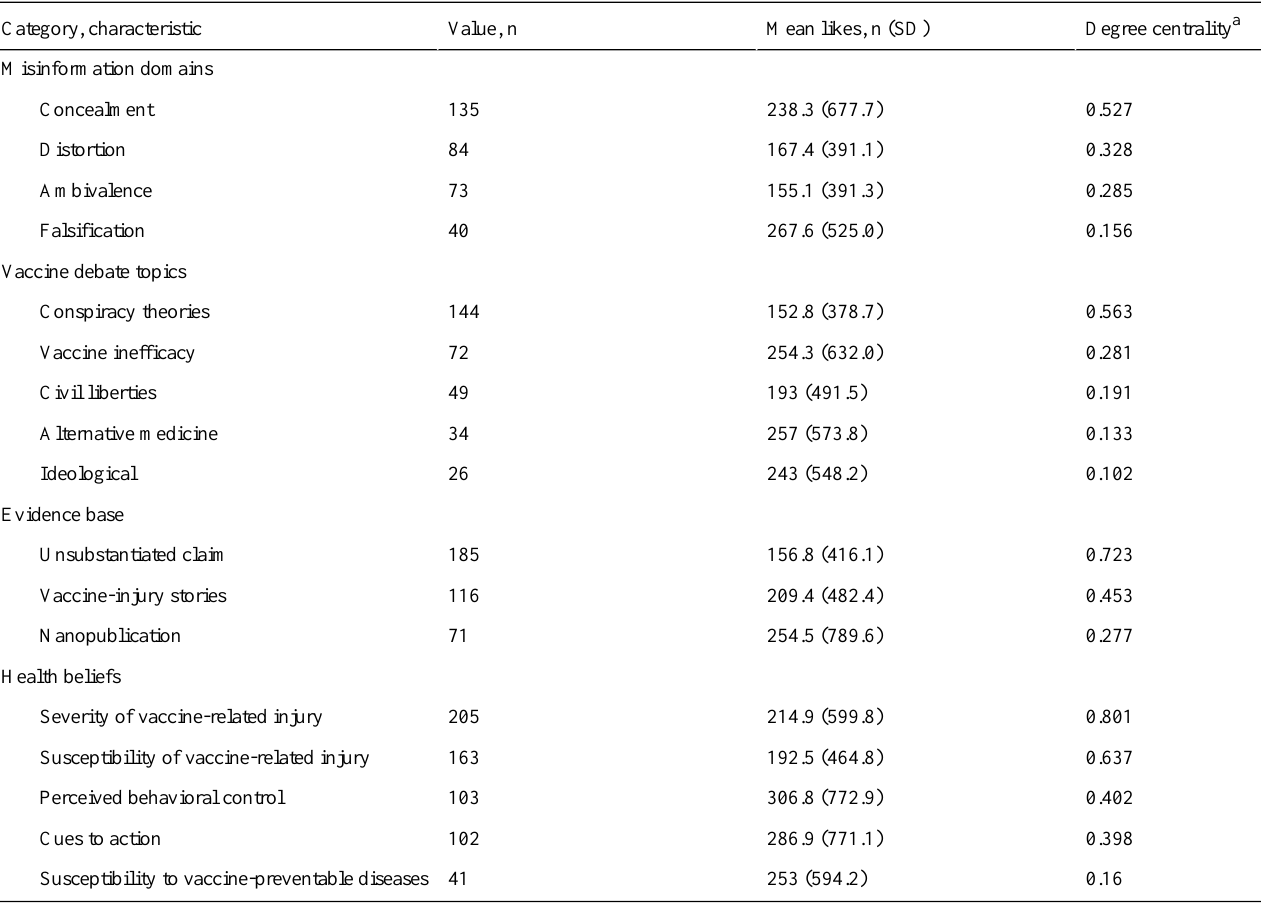
Table 2. Frequency and proportion of misinformation characteristics of antivaccine Instagram posts (n=256). Results ordered descending by frequency. All characteristics were coded independently and were not mutually exclusive. Not shown (<10%): severity of vaccine-preventable diseases, benefits of not vaccinating, barriers to not